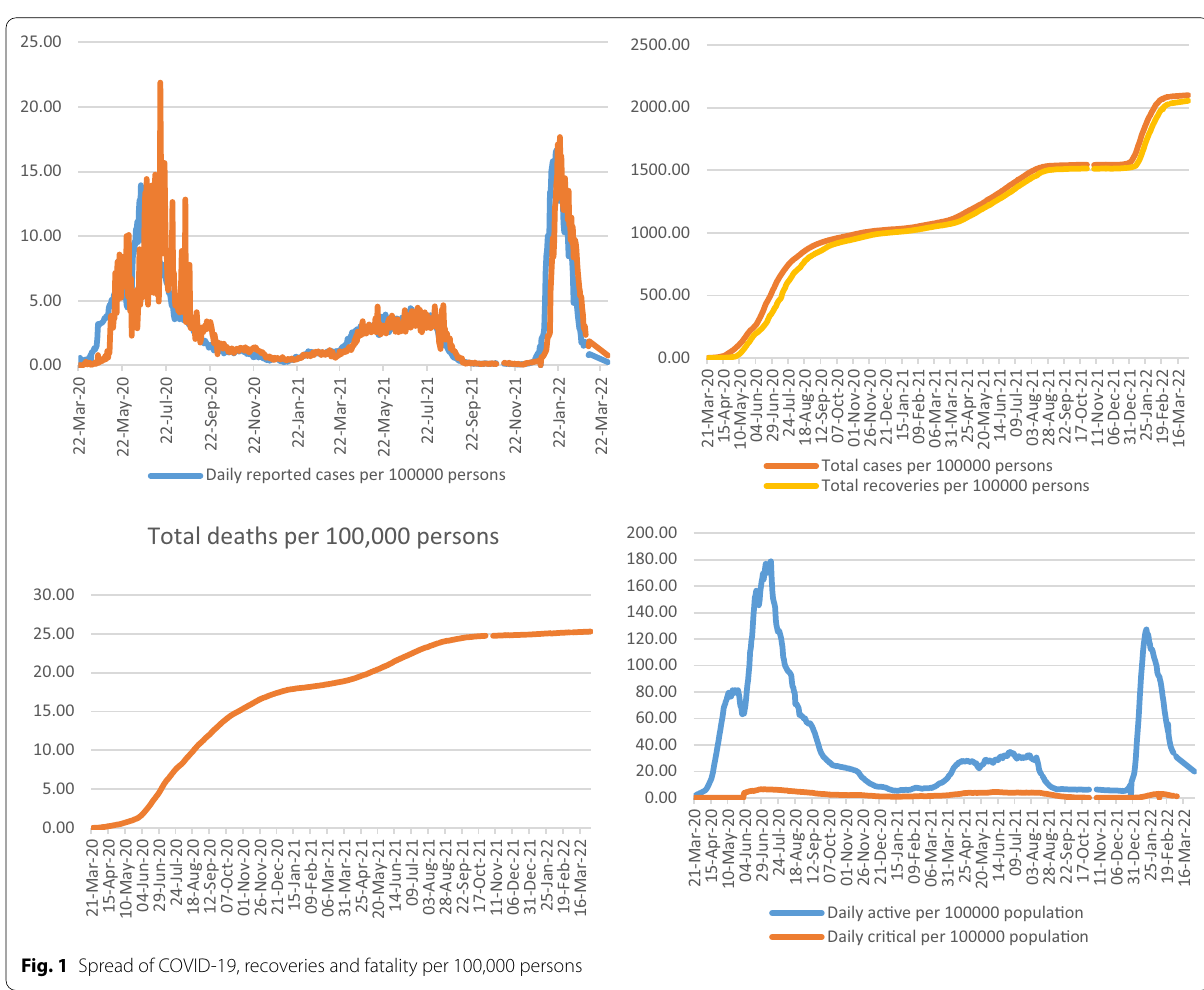
Fig. 1 Spread of COVID‑19, recoveries and fatality per 100,000